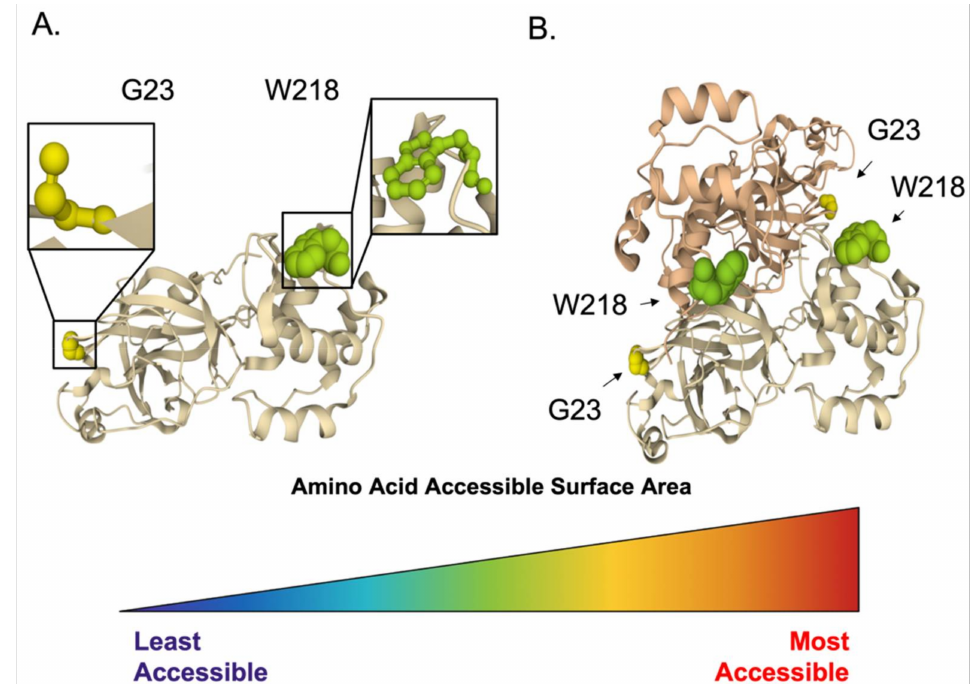
Figure 4. Conserved and accessible amino acids of CoV Protease. Identified conserved residues of interest within coronavirus Nsp5 protease crystal structure (PDB ID: 5GWY) shown as a monomer ( A ) and a dimer ( B ). Two conserved and accessible residues, G23 and W218, are highlighted with molecular surface representation and colored by amino acid accessible surface area (ASA) ranging from the least accessible (dark blue) to the most accessible